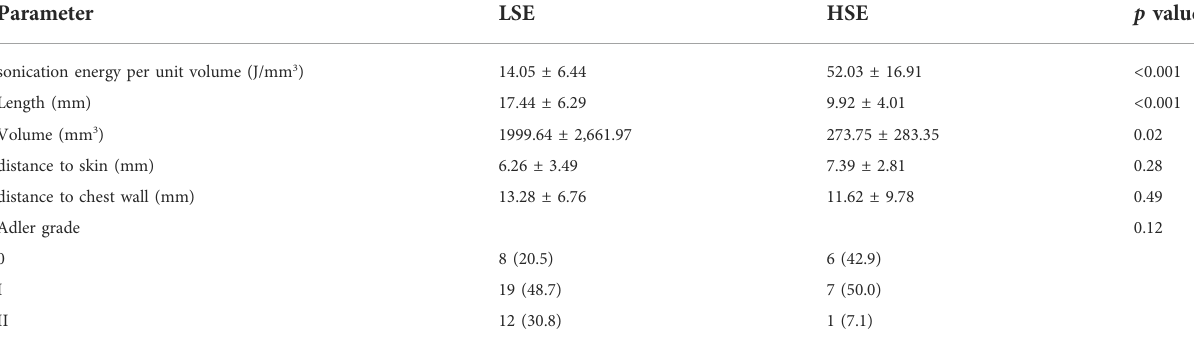
TABLE 1 Baseline characters of benign breast tumors in Group LSE and Group HSE. Categorical variables are in n (%), and continuous variables are in mean ± SD. p values were calculated between Group LSE and Group HSE. LSE, low sonication energy; HSE, high sonication energy. Parameter